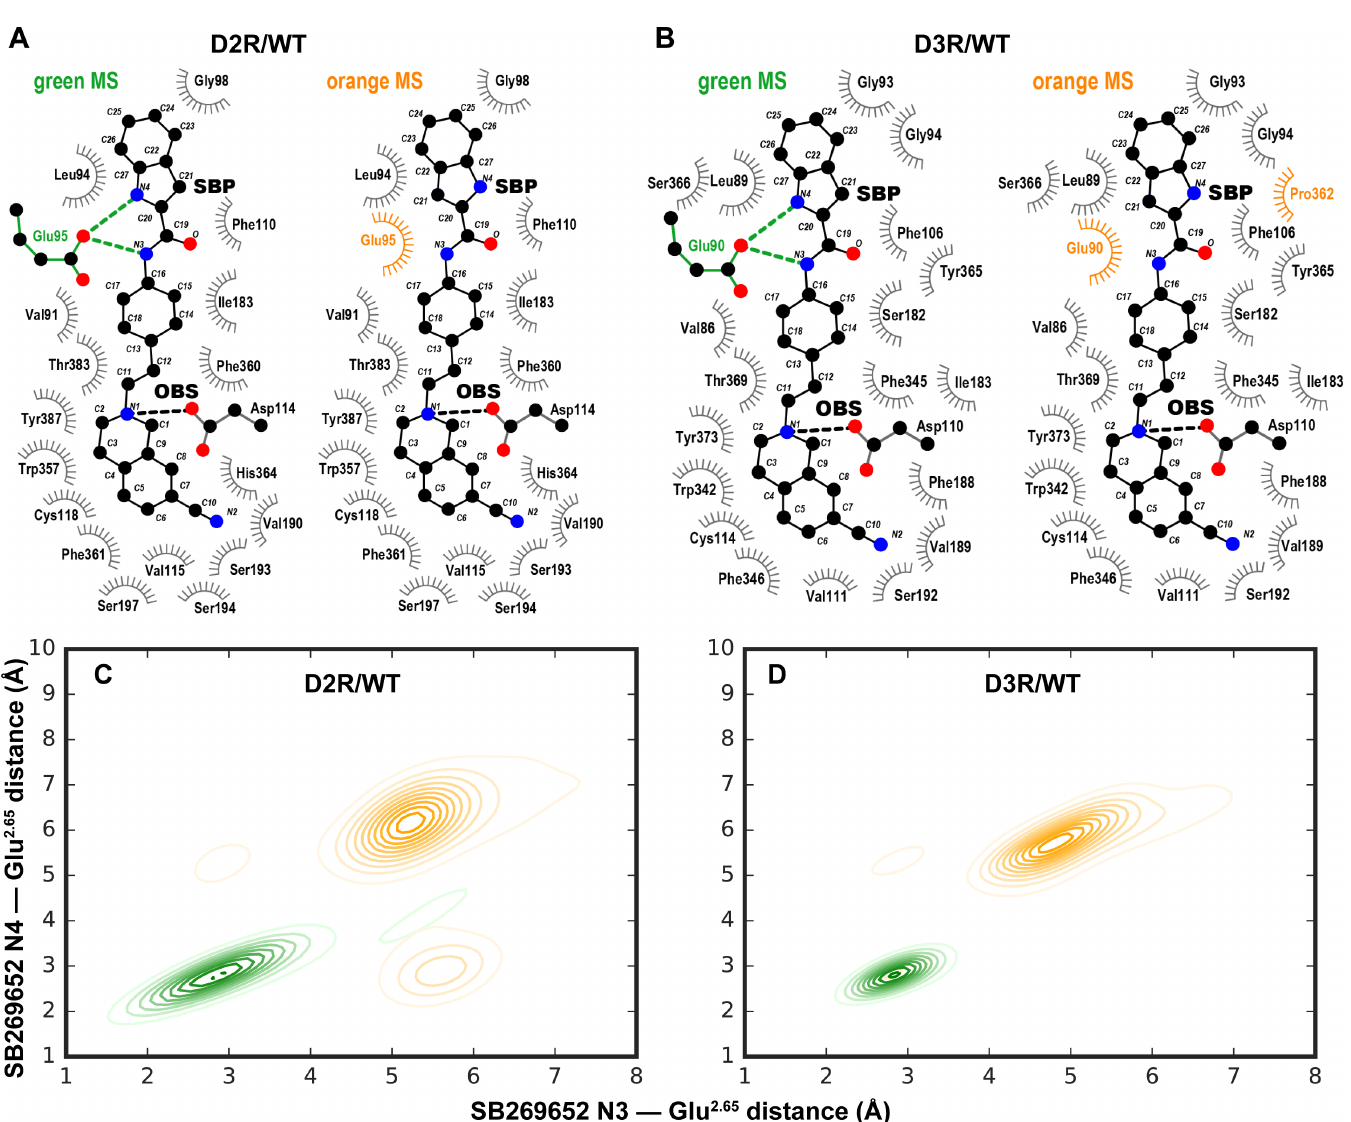
Fig 2. Different binding modes of the SP occupy similar space in each receptor. Panels A (D2R/WT) and B (D3R/WT) show the protein residues within 5 Å of the heavy atoms of SB269652 (interaction frequency > 65%, S1 Table) for the green and orange MSs. Interacting residues shared between the two MSs are shown in grey; residues forming unique interactions in one of the MSs are colored accordingly. The green MSs form direct H-bonds and the orange MSs form non-polar interactions with Glu 2.65 in both D2R/WT and D3R/WT, but the SP in green and orange MSs occupy similar spaces. Ligand interaction plots were generated using LigPlot+ [19]. The shortest distance between the N3 atom of SB269652 and the carboxyl oxygen atoms of Glu 2.65 is plotted against that between N4 and those oxygen atoms in each MS of D2R/WT (Panel C ) and D3R/WT (Panel D ), showing the similar interaction patterns of the two MSs in the two